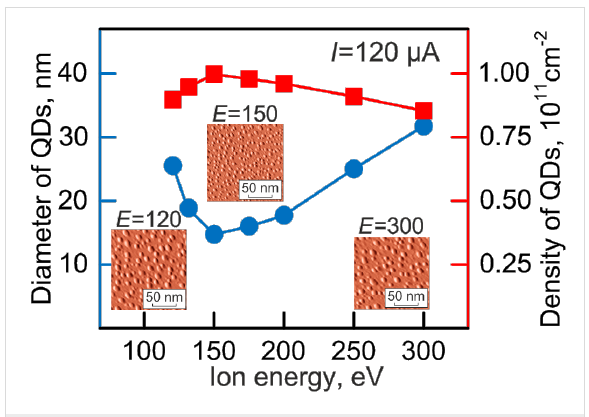
Figure 5: Average dimensions and surface density of InAs nanois- lands as a function of the ion energy.